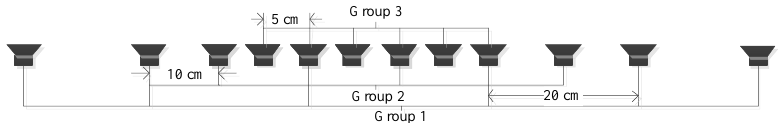
Figure 3. The designed loudspeaker array.